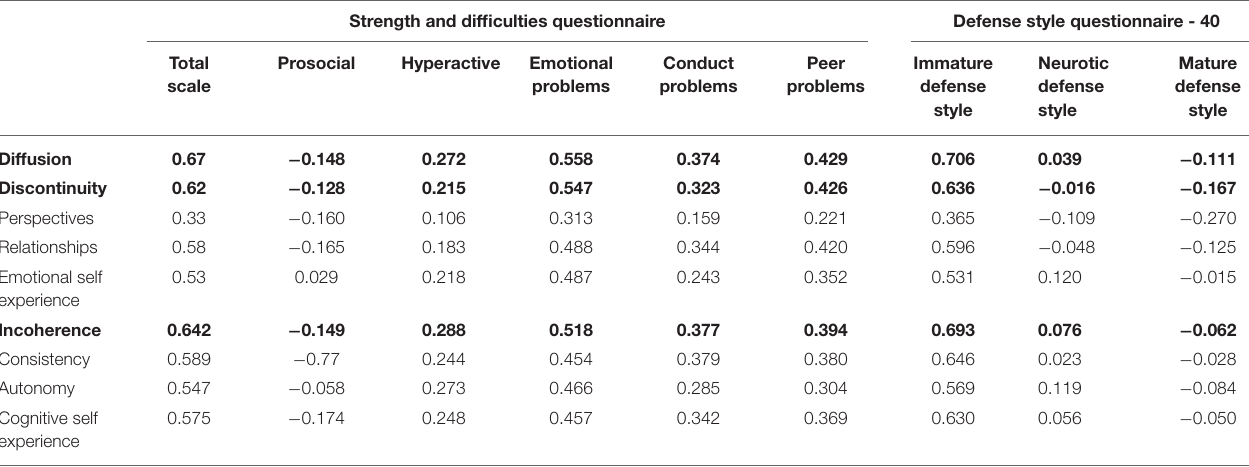
TABLE 4 | AIDA scale correlations with Strength and Difficulties Questionnaire and Defense Style Questionnaire - 40. Strength and difficulties